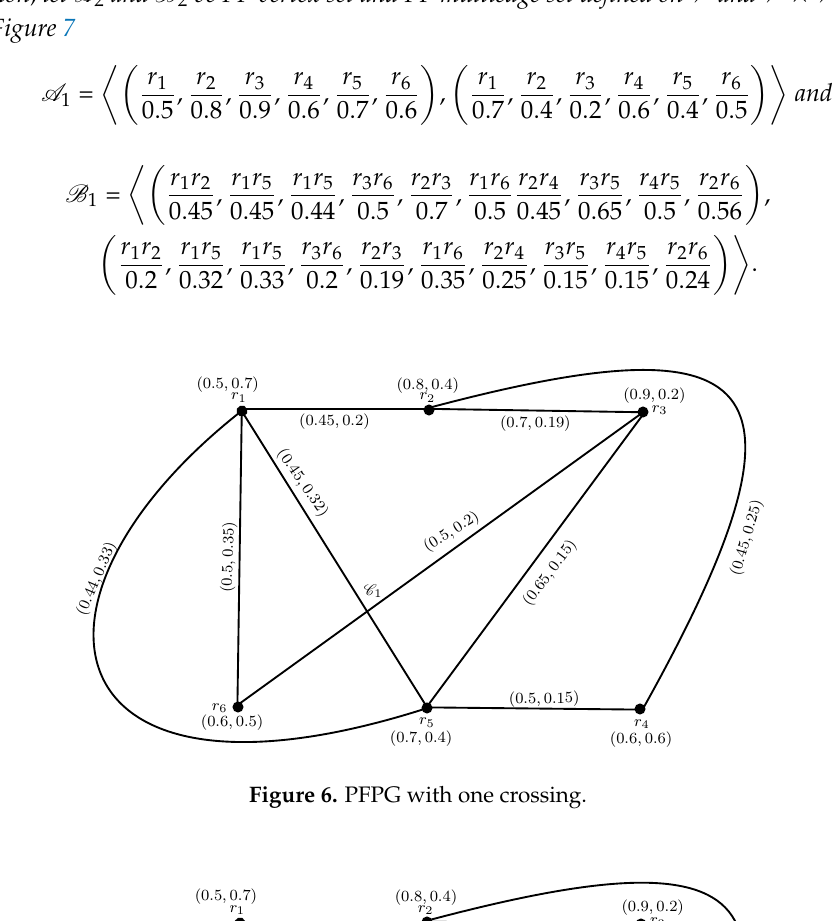
Figure 3.3: PFPG with one crossing